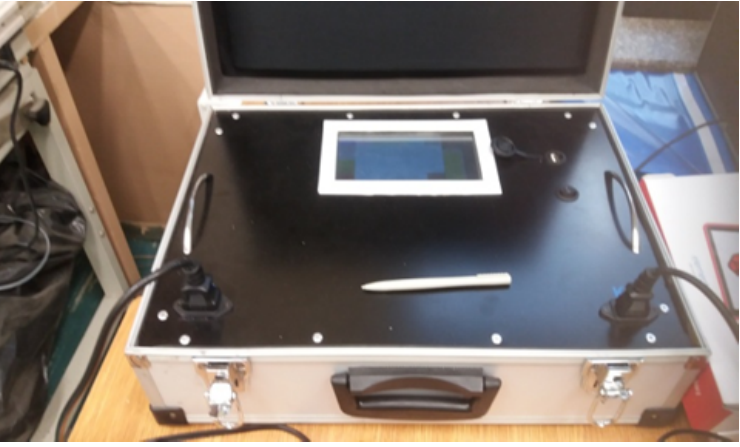
Figure 4. Photograph of the PRIME analyzer α